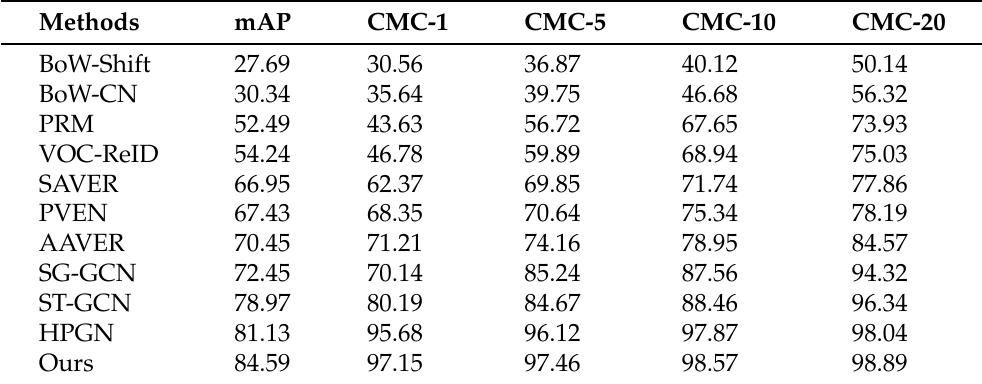
Table 2. Comparisons results(%) of object Re-ID on UAV-ReID dataset by using the metrics of mAP, CMC-1, CMC-5, CMC-10 and CMC-20, respectively.